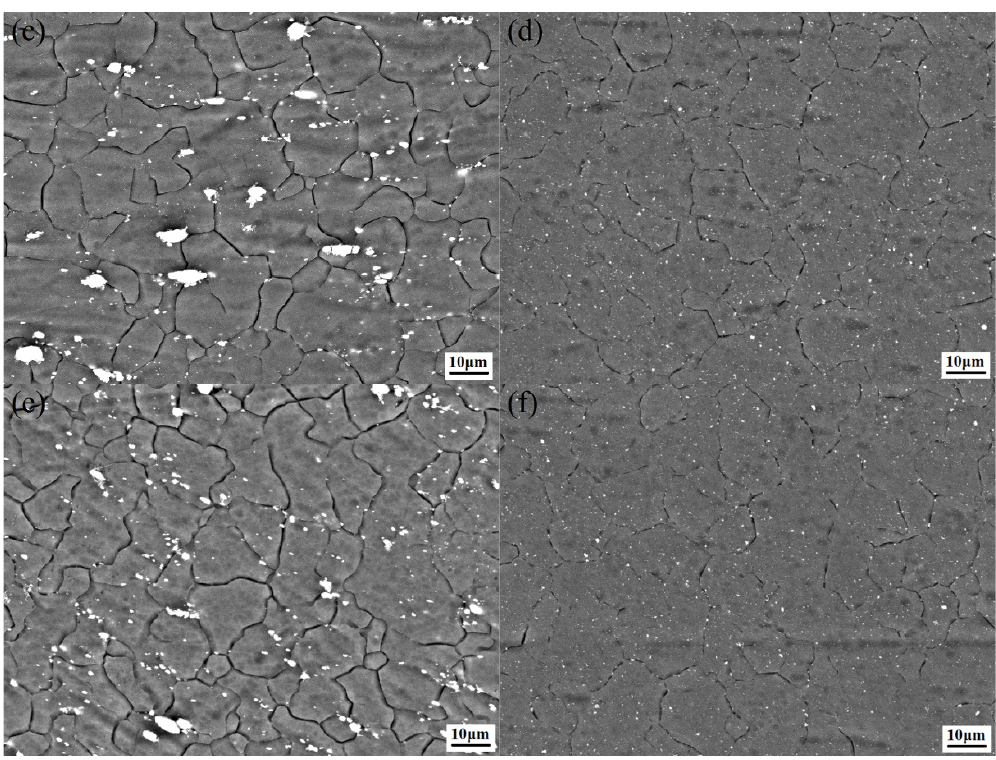
Figure 4. SEM images of different stir zone (SZ) regions in FSP Mg–6Sn–2Zn samples: ( a ) SZ-up region at 60 mm/min; ( b ) SZ-down region at 60 mm/min; ( c ) SZ-up region at 90 mm/min; ( d ) SZ-down region at 90 mm/min; ( e ) SZ-up region at 120 mm/min; and ( f ) SZ-down region at 120 mm/min.